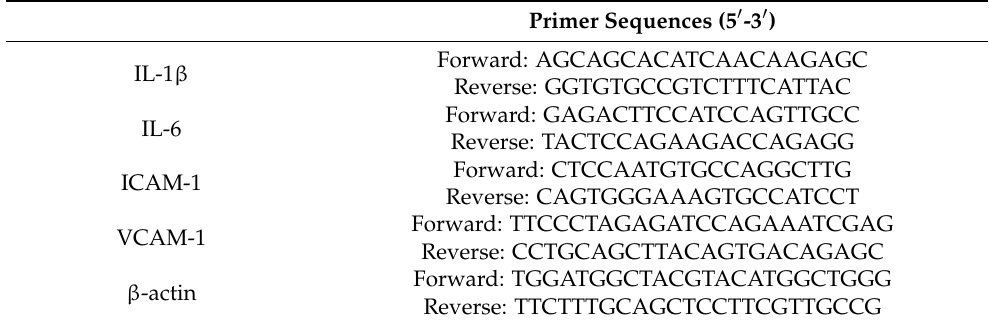
Table 1. Primer sequences used for real-time